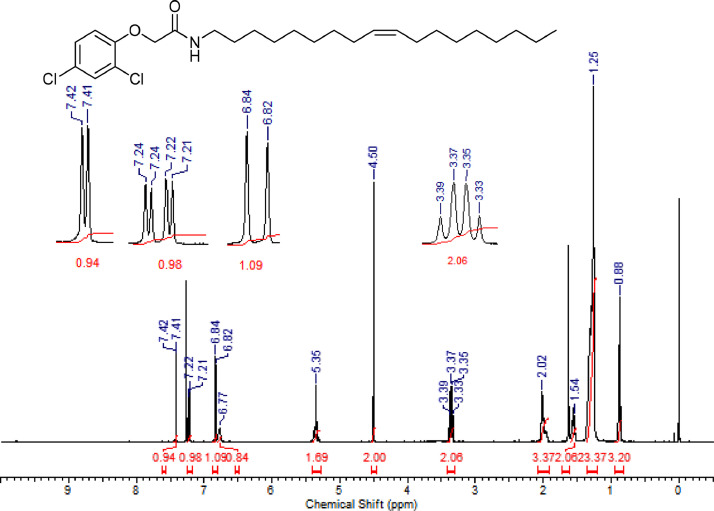
1H NMR (CDCl3, 400 MHz) spectrum of compound 8c.